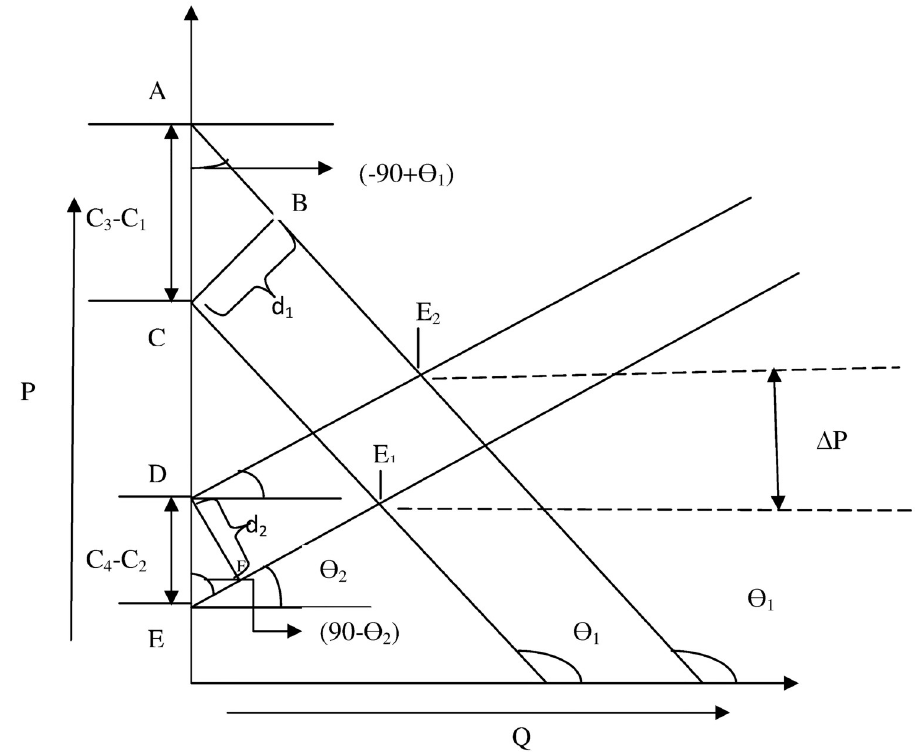
Fig 3. Impact of EM and EC on demand and